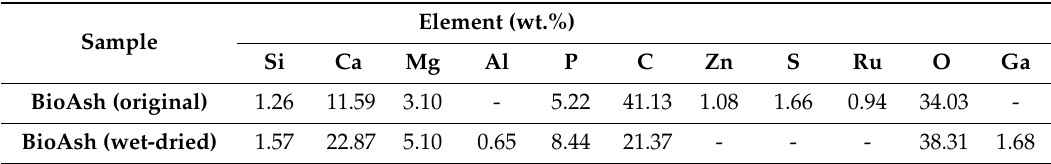
Table 4. Primary elemental composition change of original BioAsh and BioAsh after being wet-dried. Element Sample